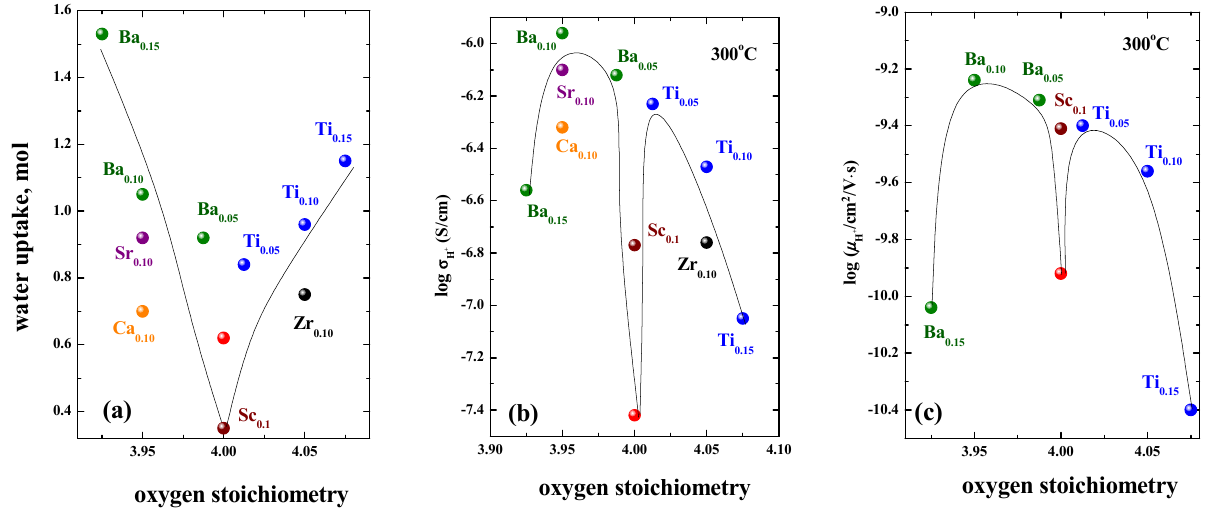
Figure 18. The water uptake ( a ), protonic conductivity ( b ) and protonic mobility ( c ) vs. oxygen stoichiometry in doped compositions based on BaLaInO 4 : BaLaIn 0.9 Sc 0.1 O 4 (Sc 0.1 ) [83], BaLaInO 4 (red symbol) [74], Ba 1.05 La 0.95 InO 3.975 (Ba 0.05 ) [79], Ba 1.1 La 0.9 InO 3.95 (Ba 0.1 ) [79], Ba 1.15 La 0.85 InO 3.925 (Ba 0.15 ) [79], BaLa 0.9 Ca 0.1 InO 3.95 (Ca 0.1 ) [74], BaLa 0.9 Sr 0.1 InO 3.95 (Sr 0.1 ) [74], BaLaIn 0.95 Ti 0.05 O 4.025 (Ti 0.05 ) [80], BaLaIn 0.9 Ti 0.1 O 4.05 (Ti 0.1 ) [80], BaLaIn 0.85 Ti 0.15 O 4.075 (Ti 0.15 ) [80], BaLaIn 0.9 Zr 0.1 O 4.05 (Zr 0.1 ) [78].